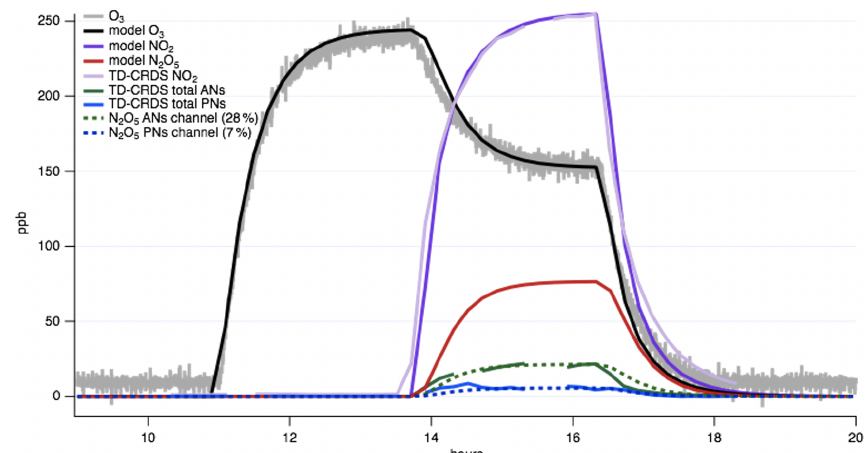
Figure 6. N 2 O 5 contribution to TD-CRDS channels assessed by an oxidant-only chamber experiment. Allowing (measured) NO 2 and O 3 to stabilize sequentially enables prediction of N 2 O 5 concentration (red trace) using a kinetics box model, such as KinSim (Peng and Jimenez, 2019). Then, the signal in the PN and AN channel of the TD-CRDS can be examined during the N 2 O 5 rise time, and percentages can be applied to assess the fraction of N 2 O 5 that is detected in each channel. For our TD-CRDS, this analysis reveals these percentages are 7% in the PN channel and 28% in the AN channel.